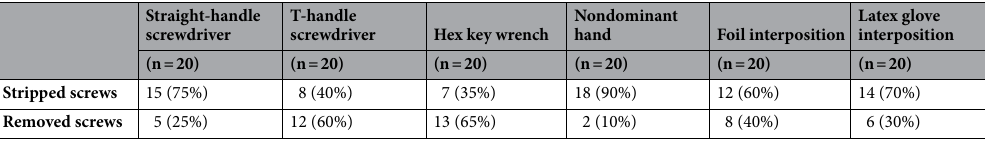
Table 1. Incidence of stripping during removal of jammed screws.